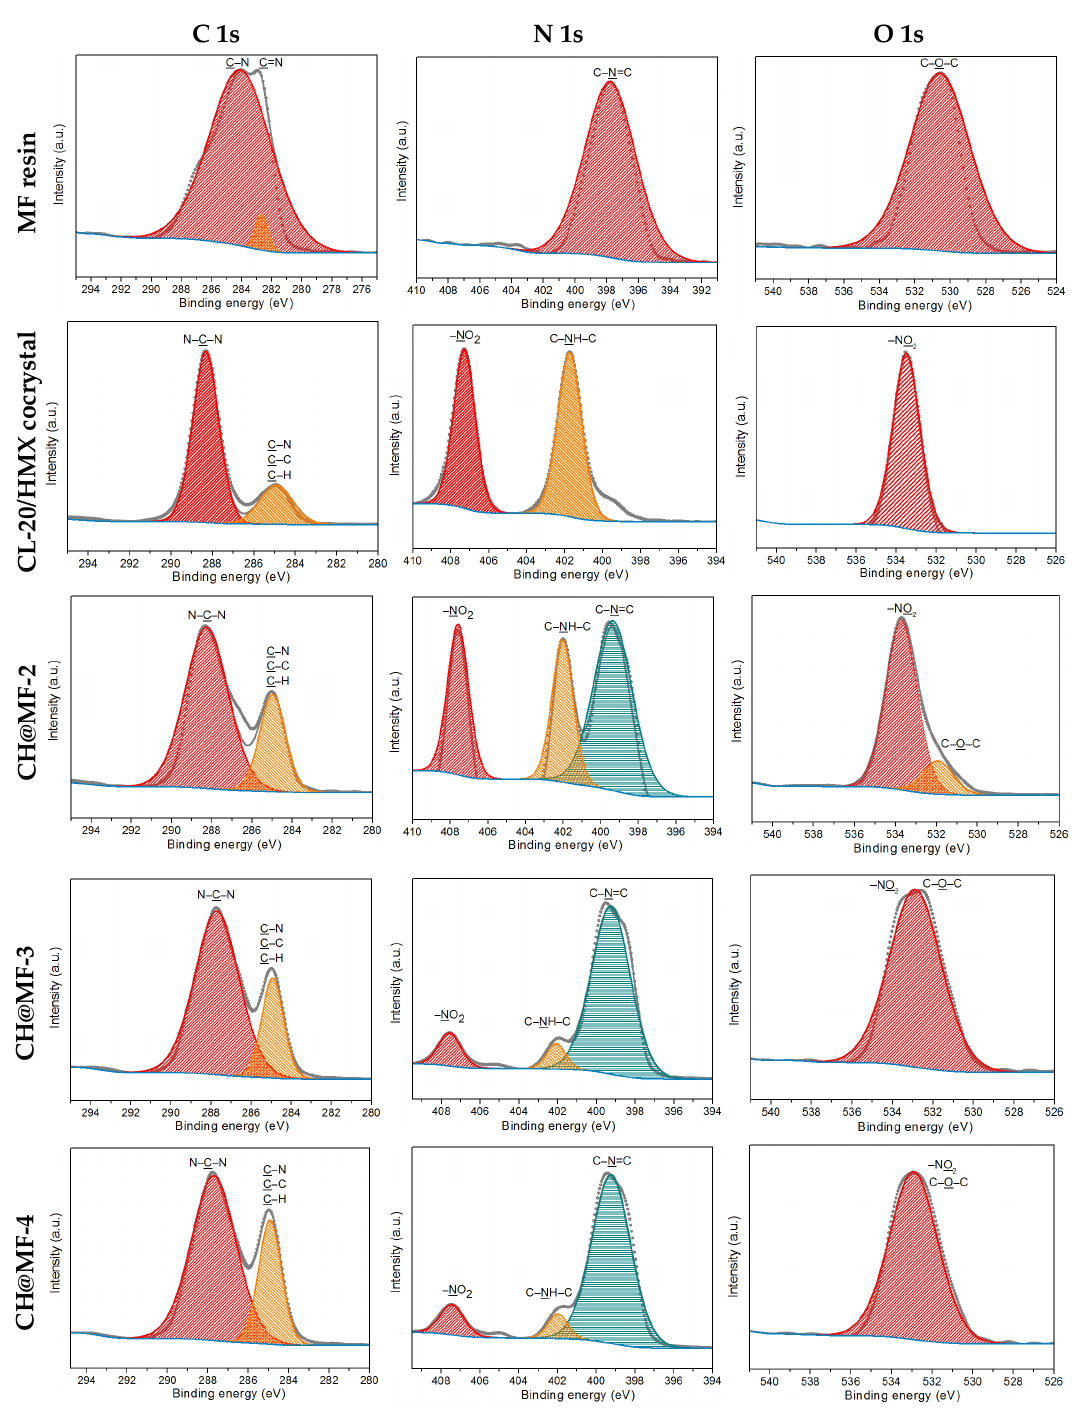
Figure 6. XPS spectra of the C 1s, N 1s and O 1s regions for the MF resin, CL-20/HMX cocrystal and corresponding CH@MF composites, respectively.